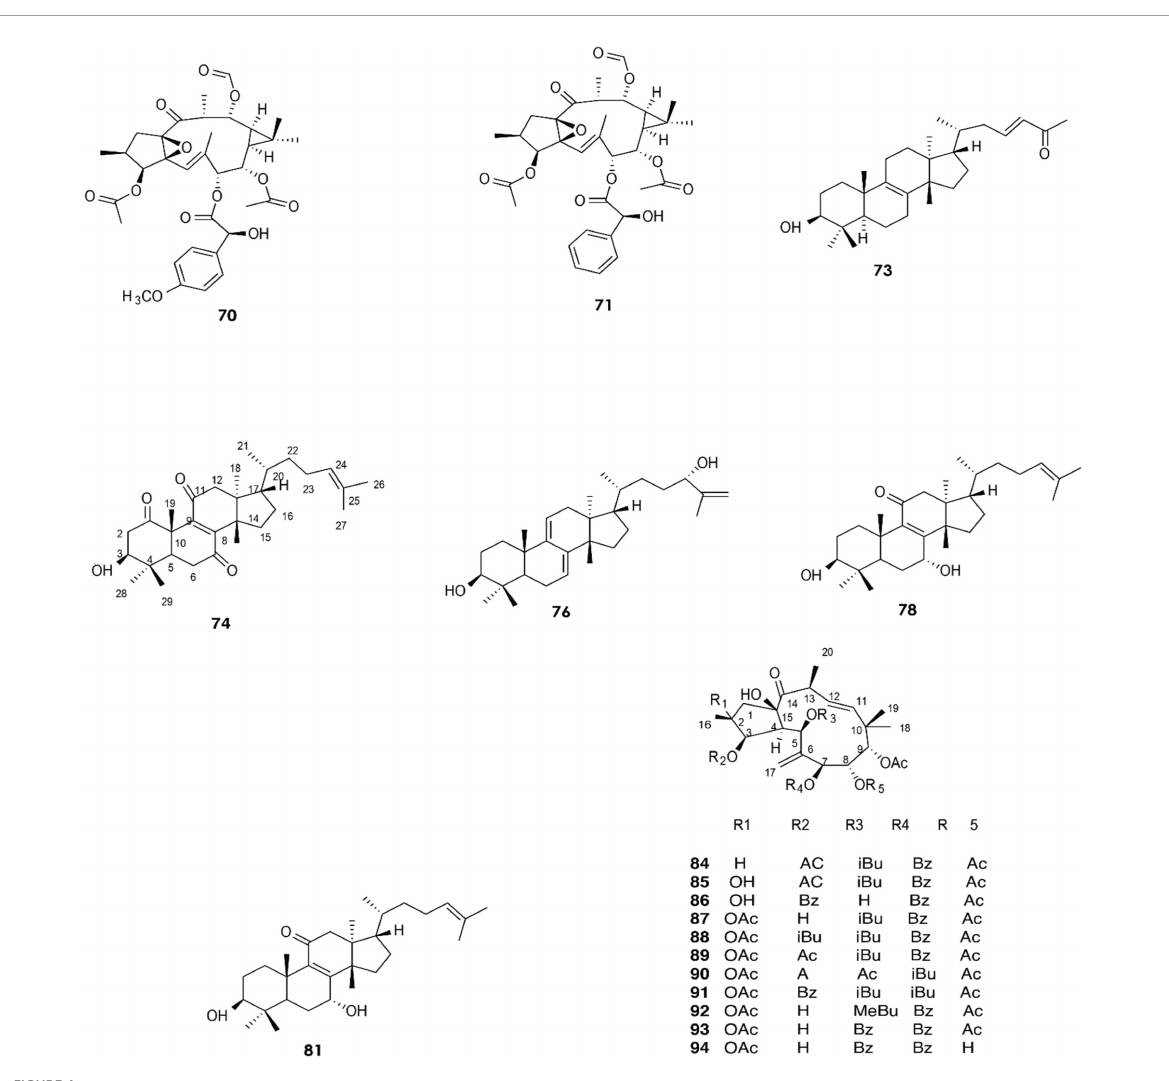
FIGURE4 Structure of chemicals compounds (70-74; 76; 78; 81) and (84-94) (Esposito et al., 2016; Li et al.,